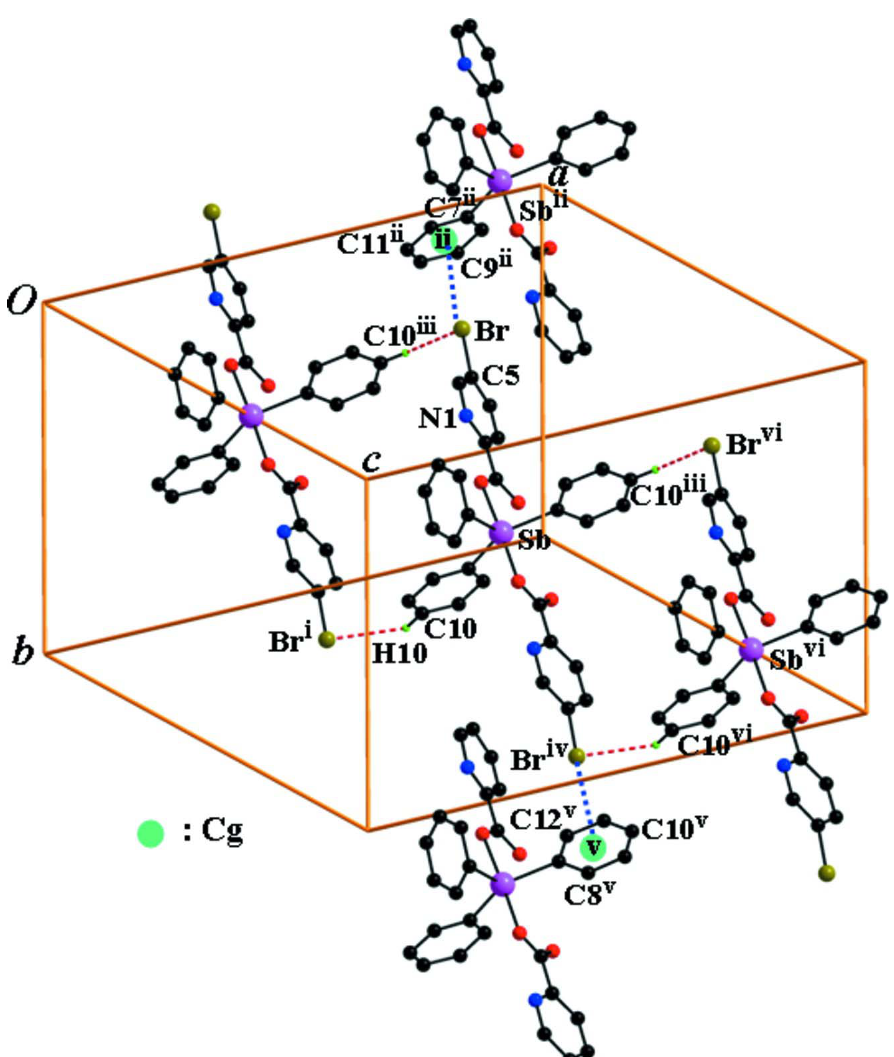
Figure 2 C—H···Br and C—Br··· π interactions (dotted lines) in the title compound. Cg denotes the ring centroid. [Symmetry code: (i) -x+1/2, -y+1/2, z; (ii) x, y-1, z; (iii)-x+1/2, -y+1/2, z; (iv) -x+1, -y+1, z; (v) -x+1, -y+2, z; (vi) x+1/2, y+1/2,